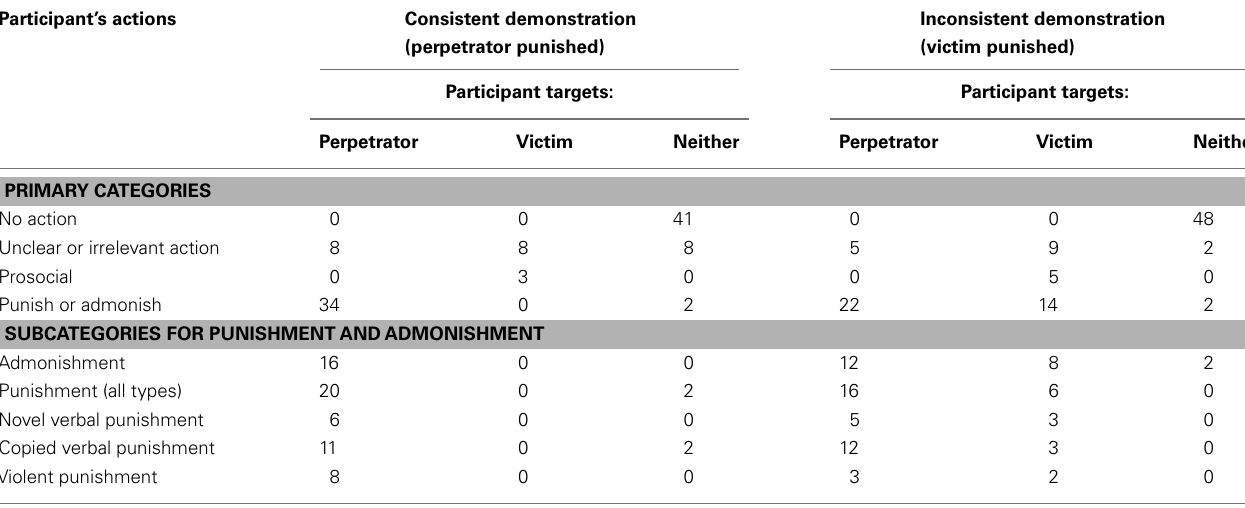
Table 2 | Mean percentage of trials in which participants caused the adult doll to perform certain